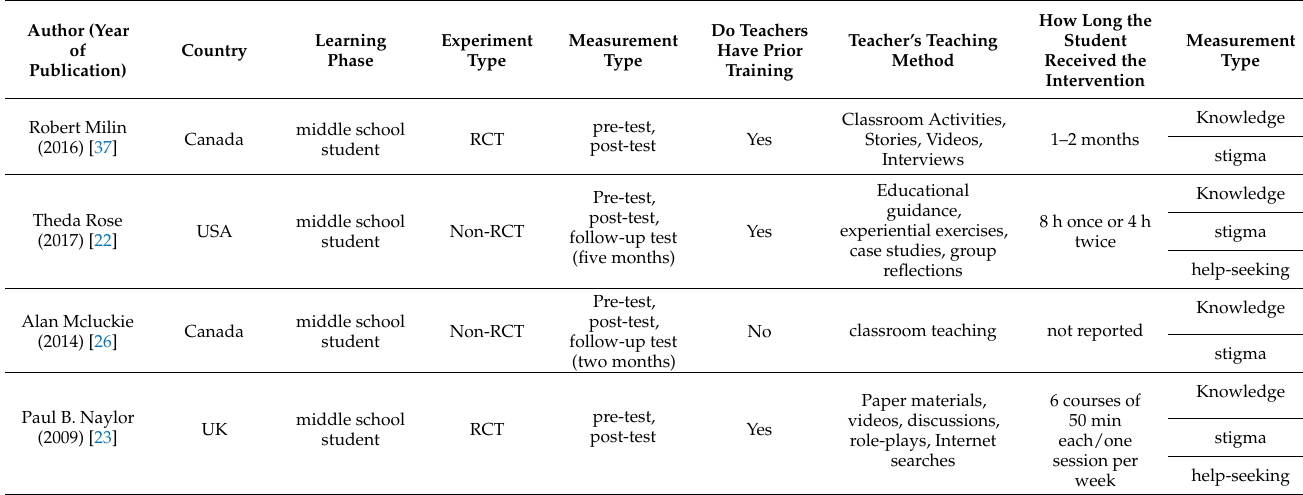
Table A1. Original Research